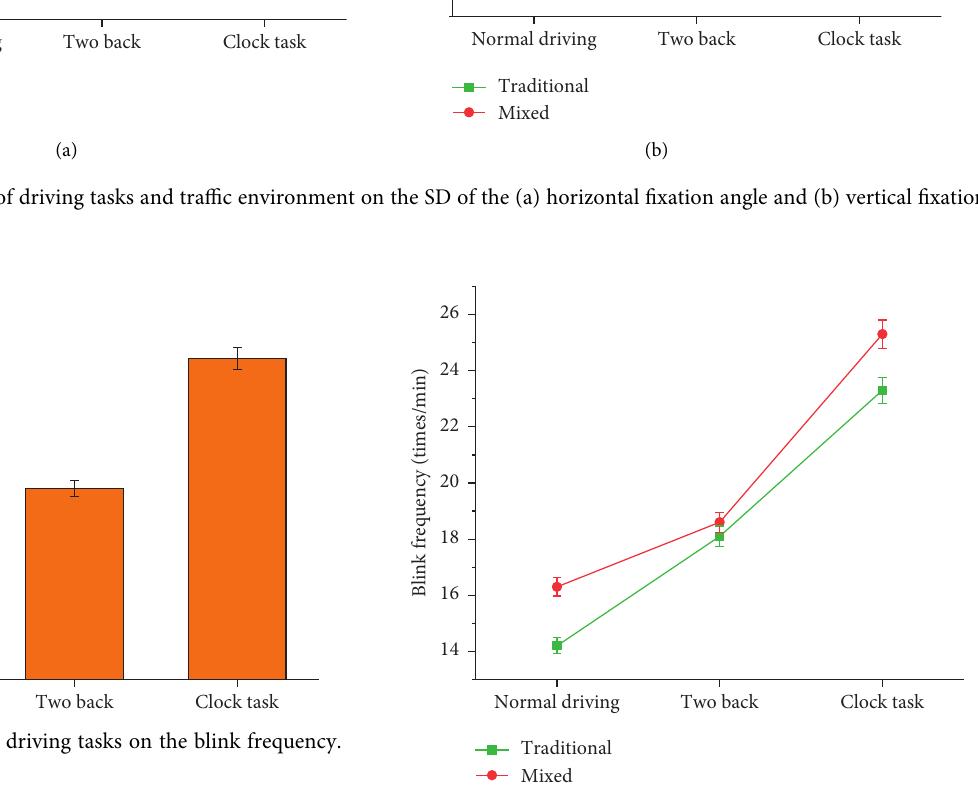
Figure 10: Interaction effect of the driving tasks and environment on the blink